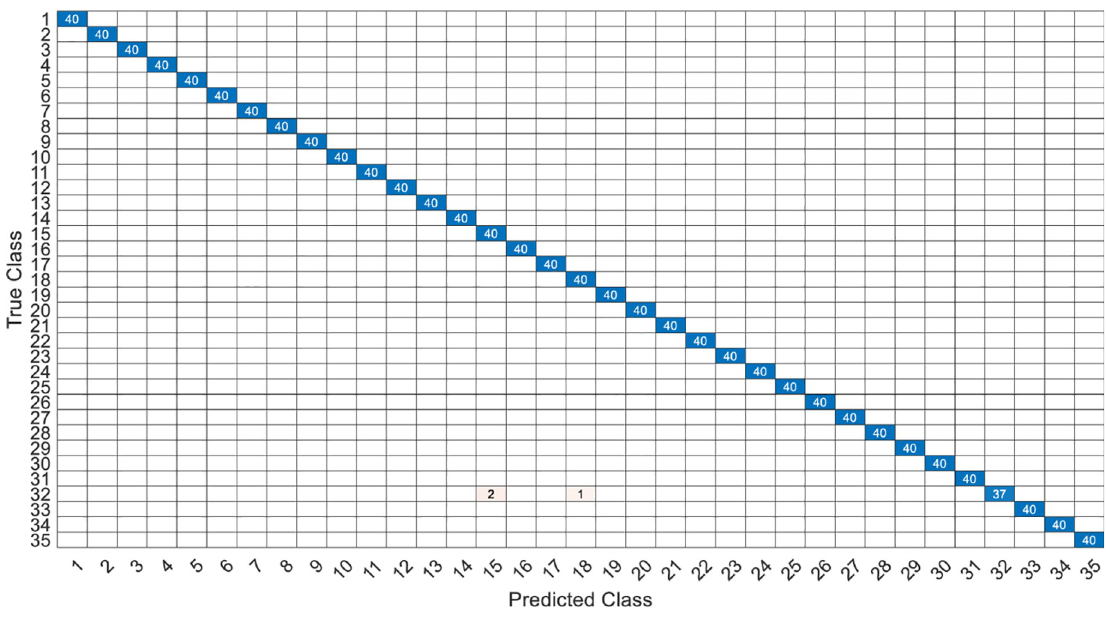
Fig 37. The confusion matrix of LSTM-2 × 200 model with MFCC datasets.